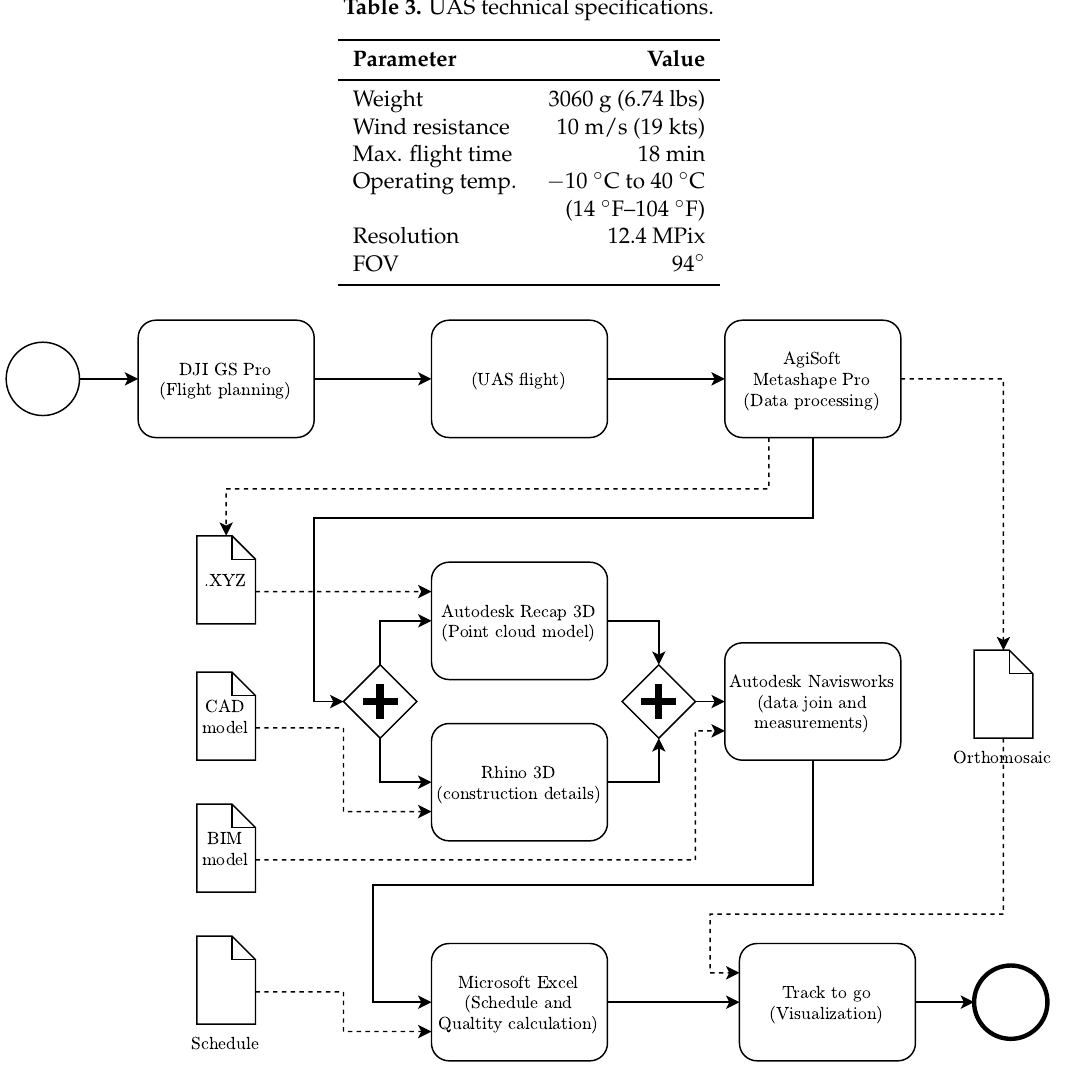
Figure 9. Case study software